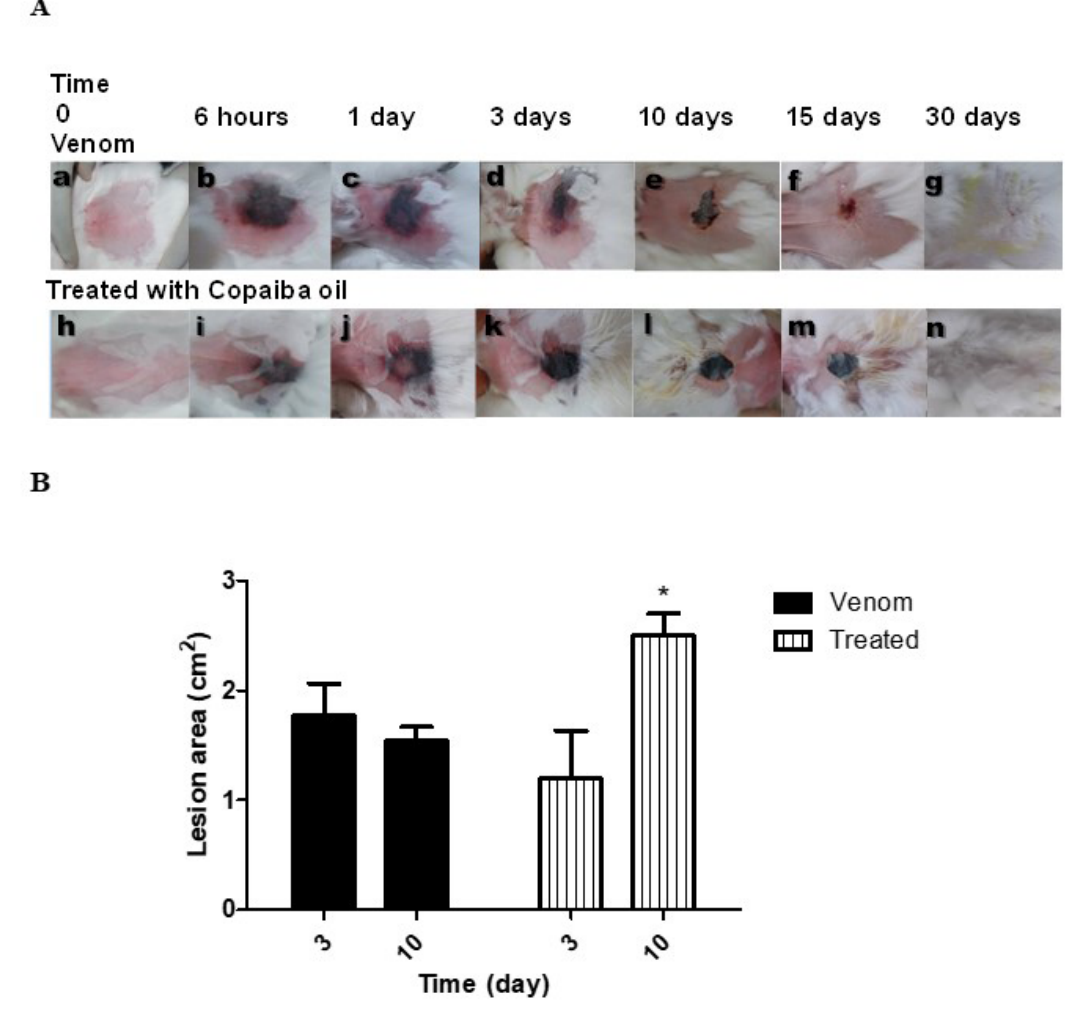
Figure 2. Evolution of the lesion 30 days after Loxosceles intermedia venom injection. Macroscopic comparison of animals that received only the venom, compared to those treated with copaiba oil after venom inoculation showed lesions with smaller area and with mild erythema. The copaiba oil induced a formation of thicker crust more delimited, without the presence of scarring on the skin (a) . Ten days after venom injection the lesion area of the group that received the treatment with copaiba oil was larger than the untreated group (b) . n = 4 animals per experimental